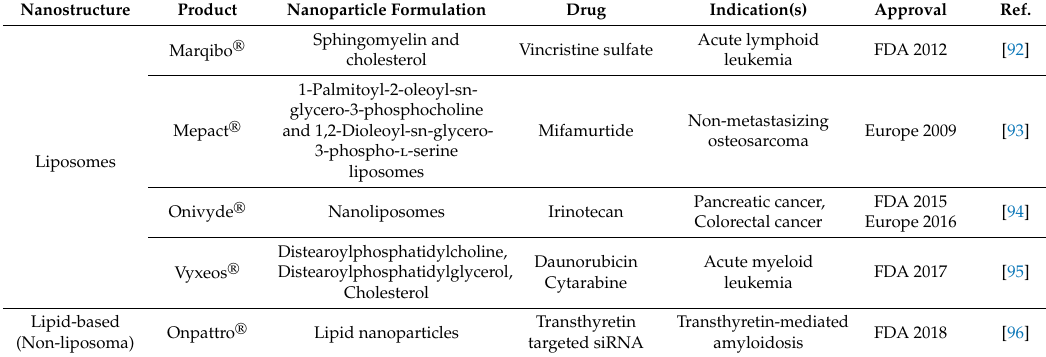
Table 1. Food and Drug Administration (FDA)- and European Medicines Agency (EMA)-approved therapeutic nanoparticles since